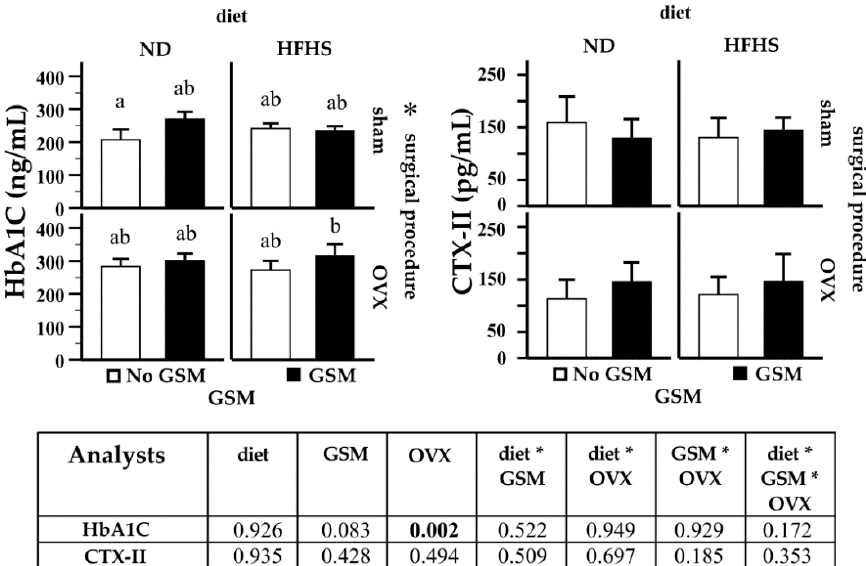
Figure 4. Analysis of cartilage and glucose metabolism in systemic circulation. Plasma analysis was measured in the rats at 48 weeks of age. Bar graphs and error bars show means and SE respectively ( n = 11–12, per group). Two-way ANOVA was used to evaluate the influence of effects: diet, surgical procedure, and GSM. If the effect was statistically significant, the symbol * is indicated. One-way ANOVA was used to identify significant differences across all groups. In case data reached the criteria, a multiple comparison test is performed using Turkey method, and then letters are indicated on the bar. Groups showing different letters are significant differences. The table shows p values calculated from two-way ANOVA analysis. p < 0.05 was used to determine statistical significance in all methods.